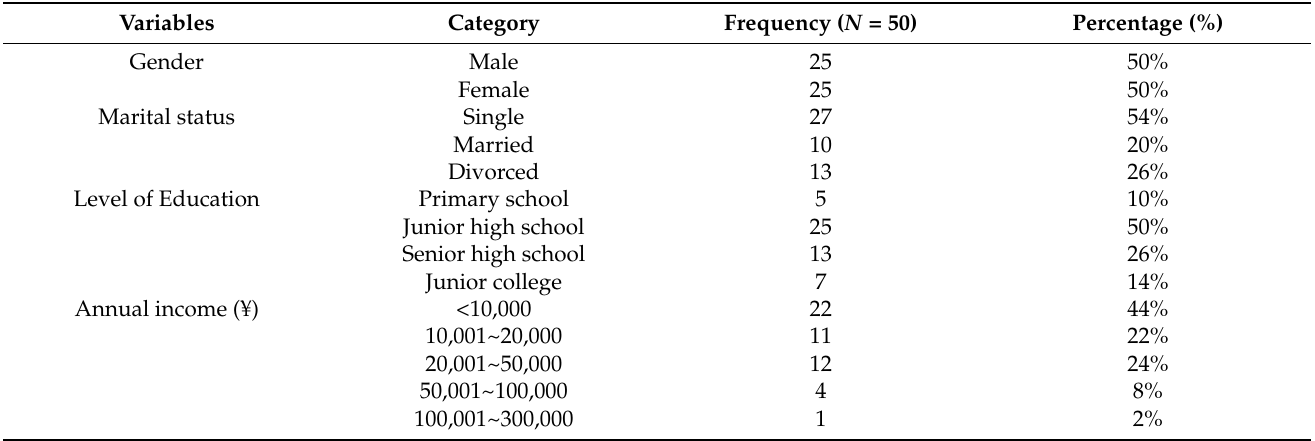
Table 2. General conditions of